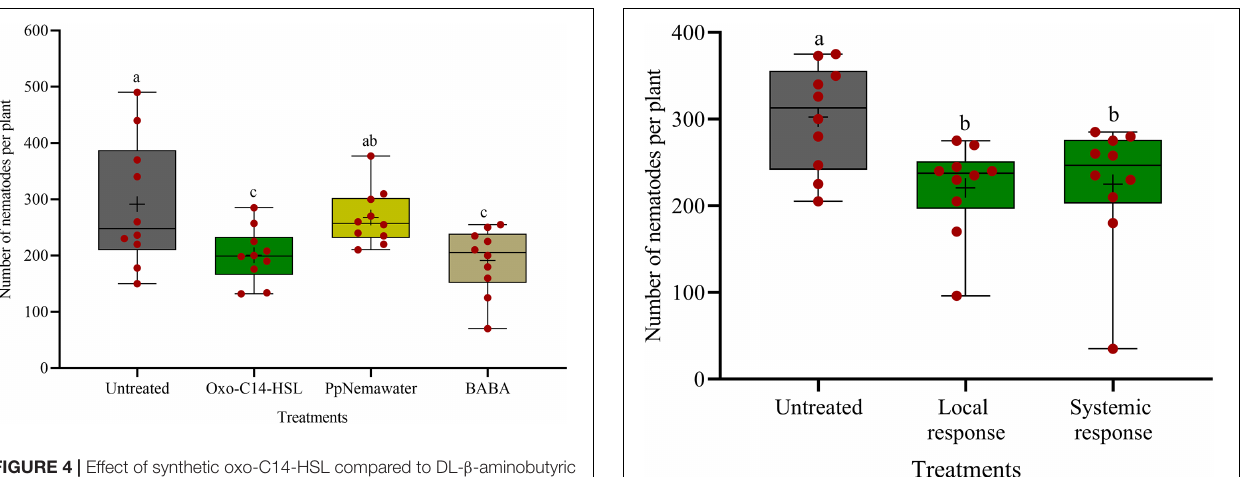
FIGURE 4 | Effect of synthetic oxo-C14-HSL compared to DL- β -aminobutyric acid (BABA) and PpNemawater on the invasion of Pratylenchus penetrans into soybean roots. Different letters indicate significant differences among treatments (SAS proc GLIMMIX, Tukey adjustment, n = 10).